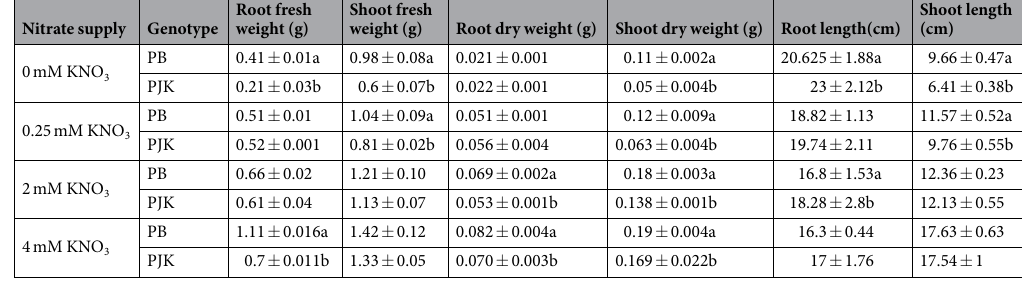
Table 1. Effect of nitrate concentration on growth characteristics. Root fresh weight (g), shoot fresh weight (g), root dry weight (g), shoot dry weight (g), root length (cm) and shoot length (cm) were measured 21 day after giving various nitrate treatment (0.25 mM KNO 3 , 2 mM KNO 3 and 4 mM KNO 3 ) in PB and PJK are shown. Data indicates mean ± S.E (n = 6). For control conditions, equal amount of KCl was supplied to the plants. Values labelled with different lowercase letters indicate significance level of difference with in the cultivars with in the treatment (p < 0.05, using